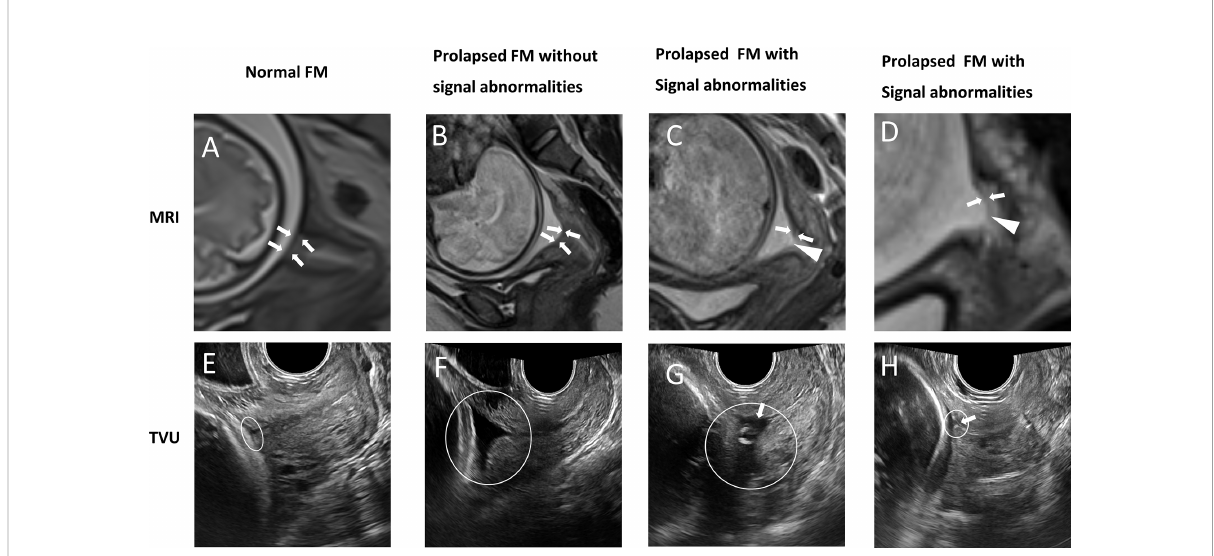
FIGURE 3 Patients underwent clinical MRI and transvaginal ultrasound (TVU) examinations on the same day. A vs. E (32wks); B vs. F (32wks); C vs. G (32wks); D vs. H (28wks). Panel (A – D) are MRI T2W images from the sagittal view. White arrows indicate the supra-cervical FM, and white triangles indicate fetal membrane defects. (A) Normal FM. (B) Prolapsed FM without signal abnormalities. (C) Prolapsed FM with signal abnormalities: partial defect of continuous FM signal. (D) Prolapsed FM with signal abnormalities: local thinning and increased signal intensity of continuous FM signal. The FM